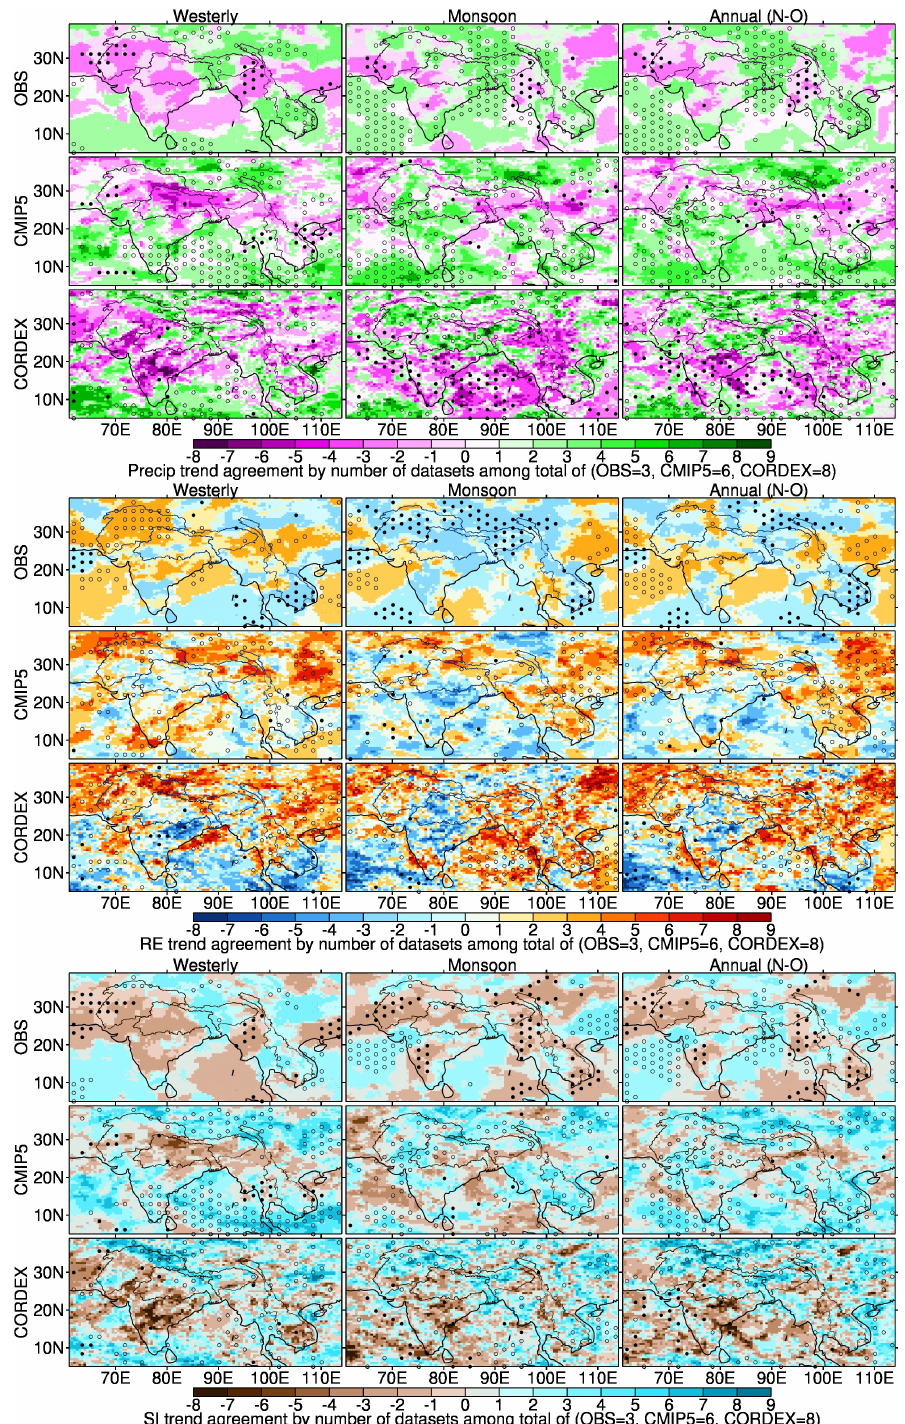
Figure 12. Agreement on trend direction and its significance: Panel top to bottom: precipitation (P), relative entropy (RE) and seasonality index (SI), Row top to bottom: OBS, CMIP5 and CX-SA ensembles. Agreement is computed as the total number of ensemble members agreeing on the positive direction minus those exhibiting the negative direction. The hollow circles show where the statistically significant positive trends (at 90% significance level) are higher in number than the significant negative trends amid ensemble members while the filled circles show the